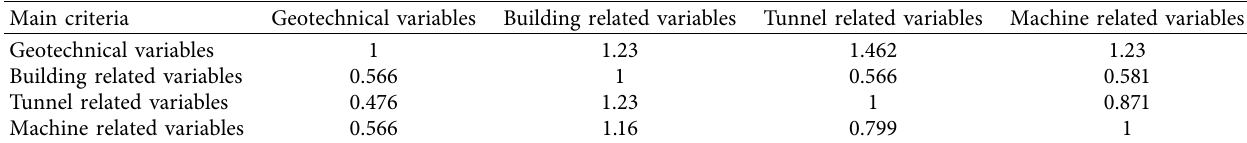
Table 8: Te weight matrix of the main criteria.